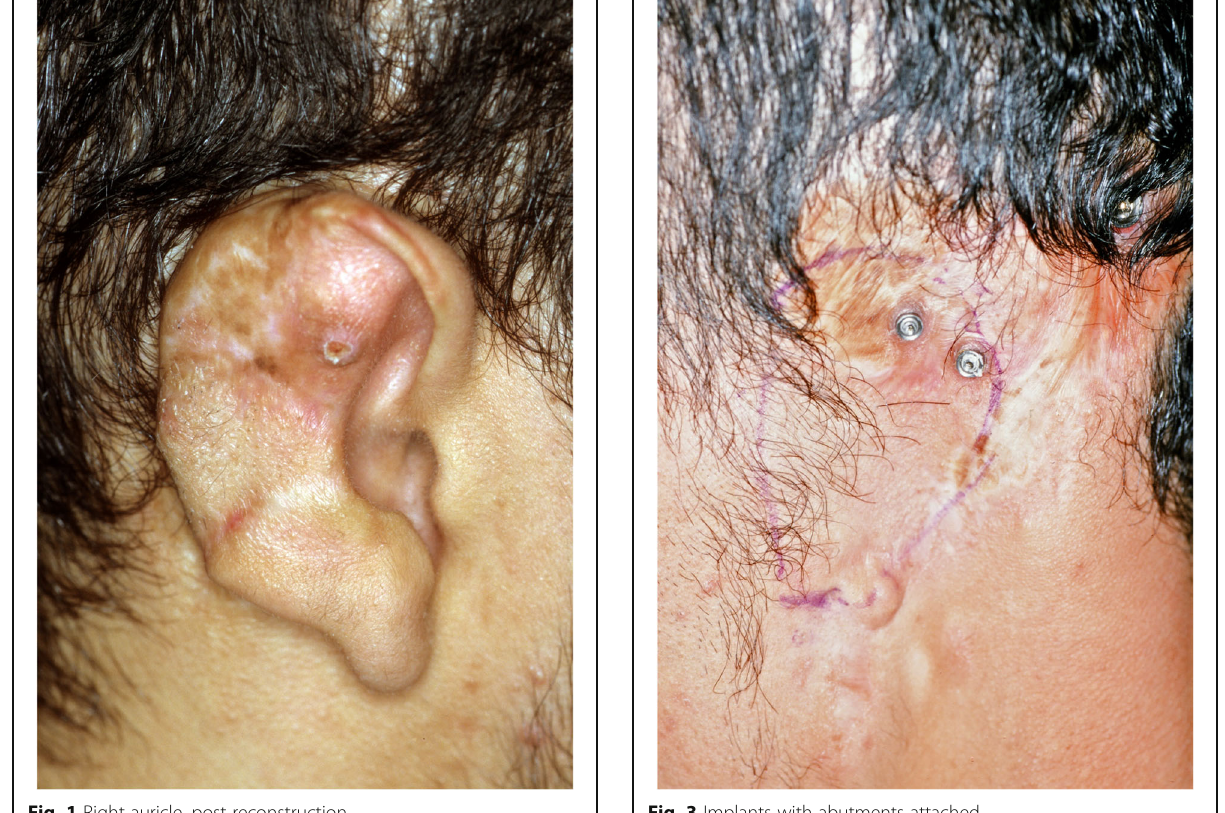
Fig. 3 Implants with abutments